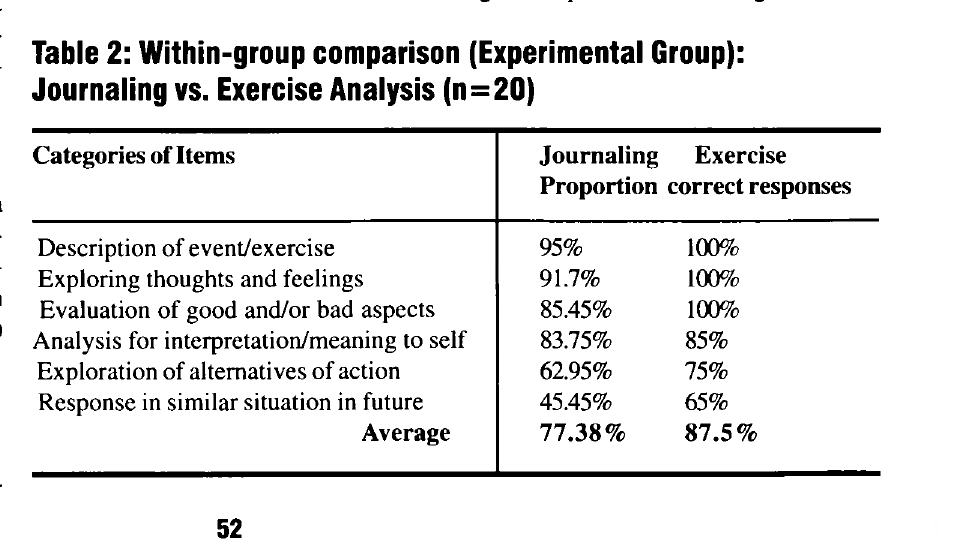
Table 2: Within-group comparison (Experimental Group): Journaling vs. Exercise Analysis